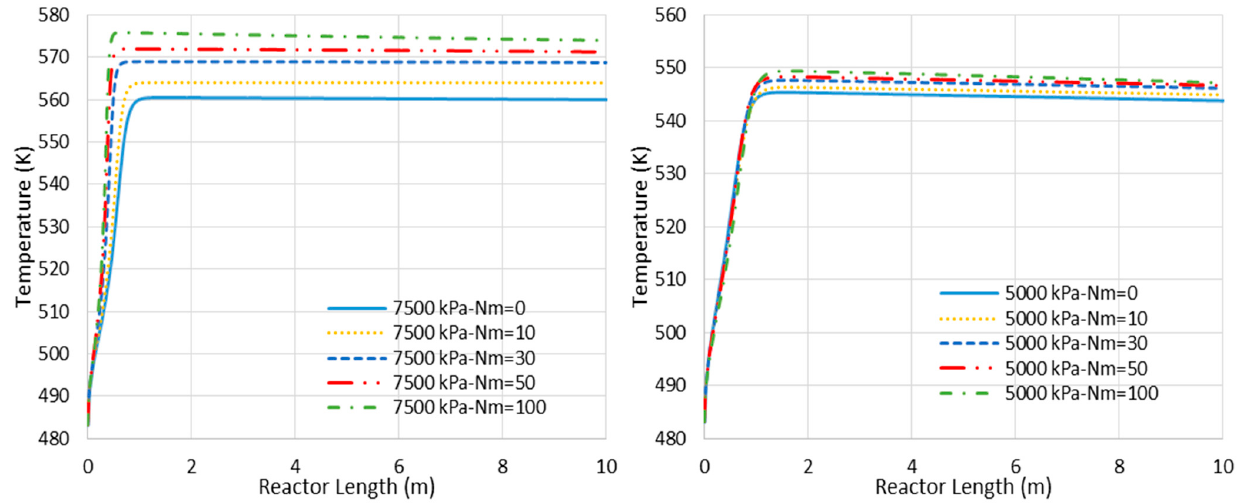
Figure 4. Temperature profile changes for CR- and MR-based processes with different membrane tube numbers (Nm) (Nm = 0 corresponds to CR).